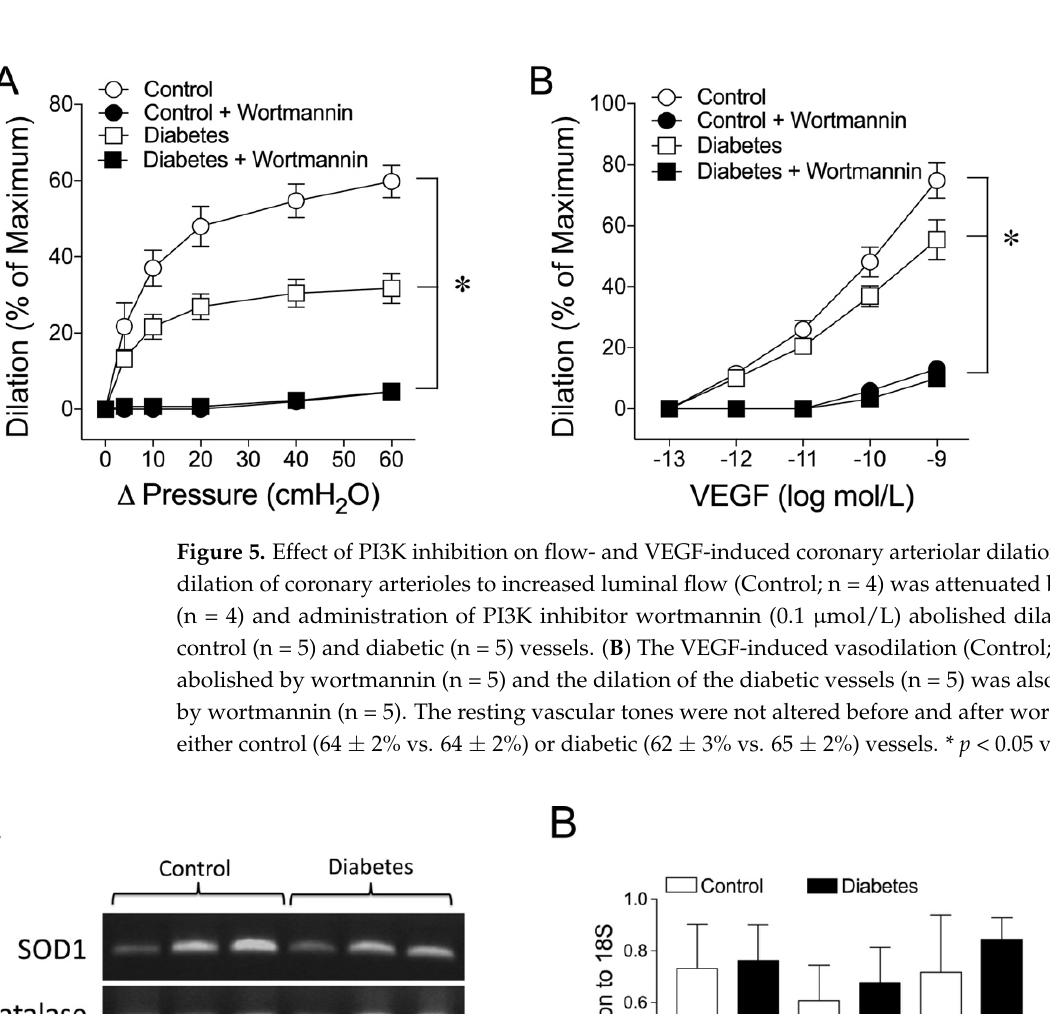
Figure 6. Effect of early diabetes on the mRNA expressions of SOD1, catalase, and GPX in isolated coronary arterioles. ( A ) The expressions of antioxidant genes (SOD1, catalase, and GPX) were de- termined by RT-PCR and the expressions were normalized to the 18S transcripts. ( B ) The quantita- tive analysis showed no difference in the antioxidant gene expressions between the control (n = 3) and diabetic (n = 3) coronary arterioles.